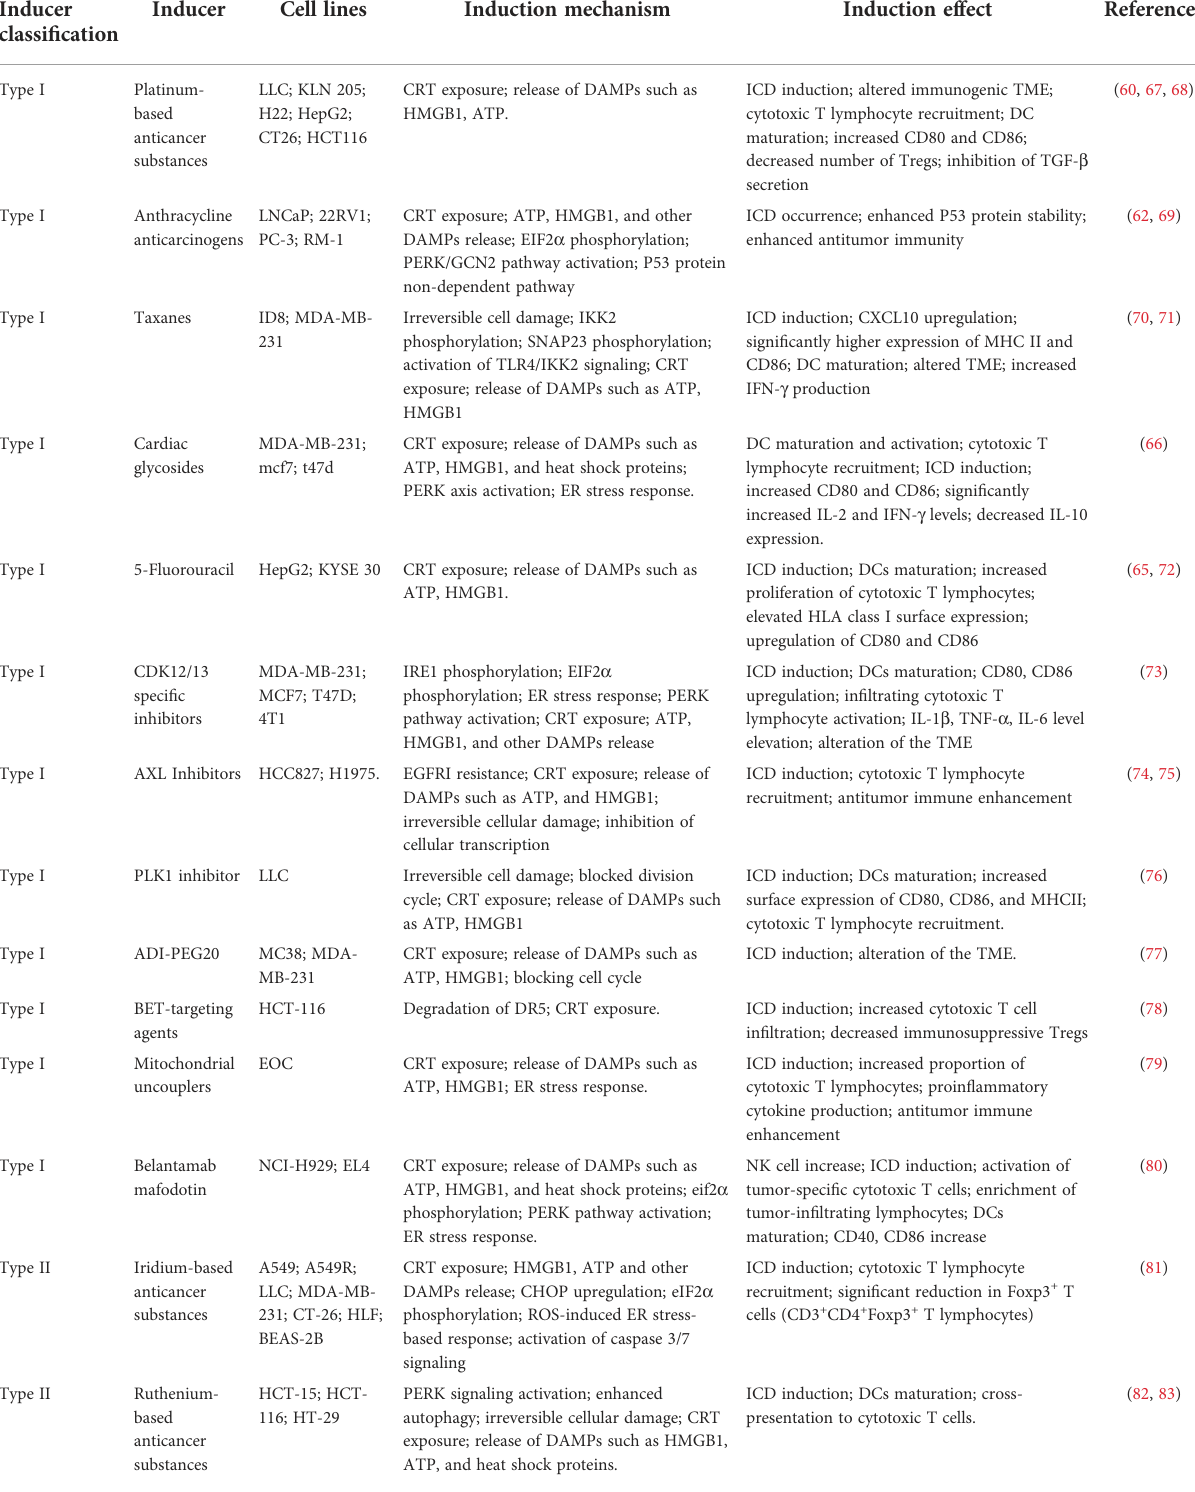
TABLE 1 Chemical sources of ICD